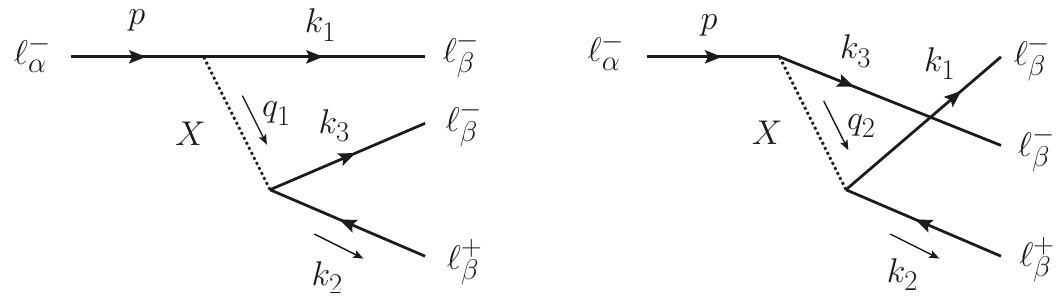
represents the SM charged α